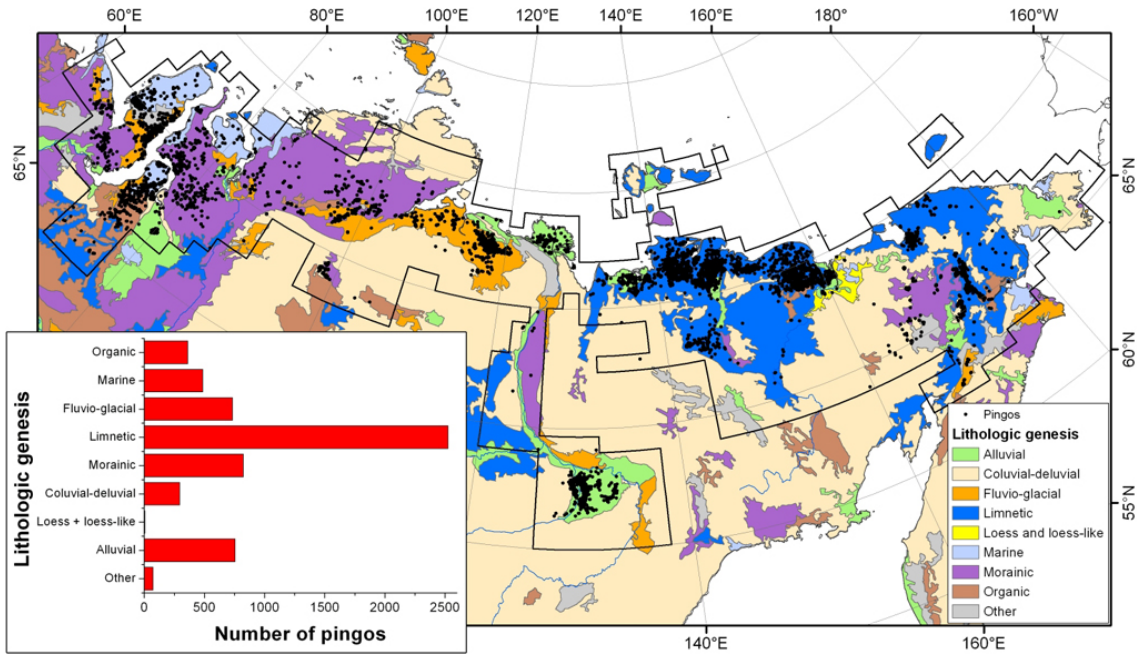
Fig. 12. Distribution of pingos by surface lithology (based on Stolbovoi et al.,